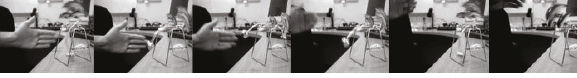
Figure 12: Frames from original